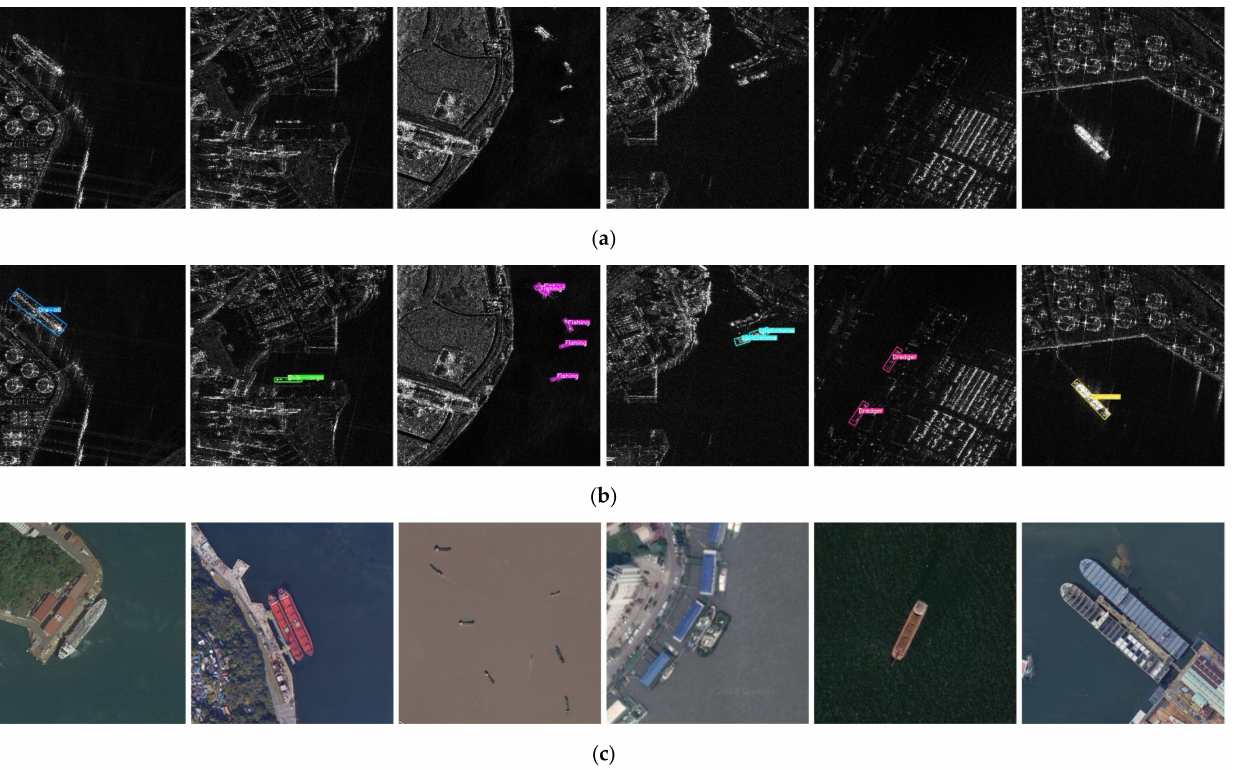
Figure 7. The distributions of the ships’ width, length, and angle on the test dataset.